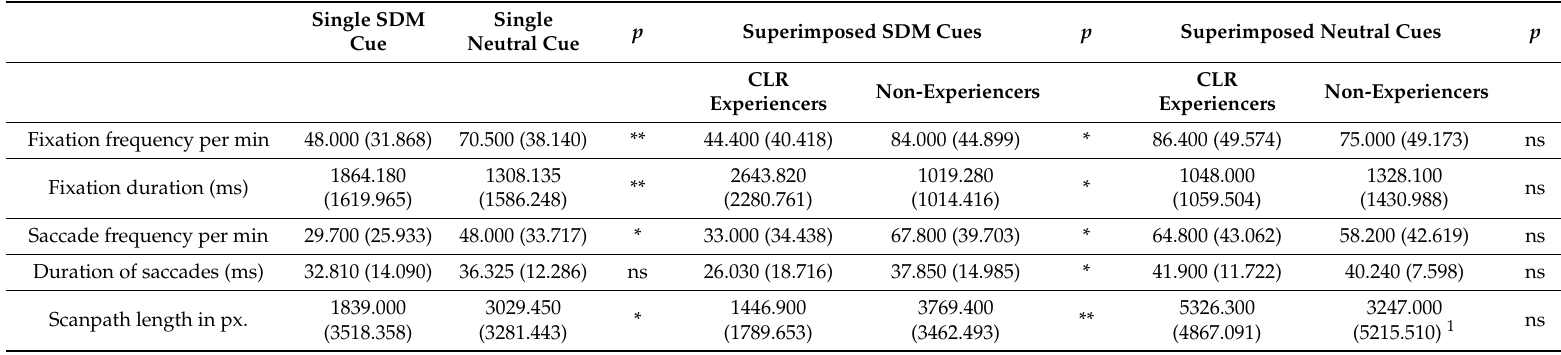
Table 2. Eye movement variations during listening to neutral phrases (single or eight superimposed) or listening to SDM cues (single or eight